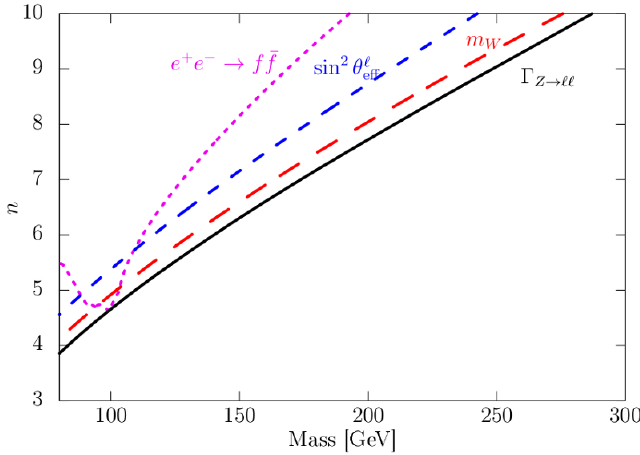
Figure 3 . The current constraints on Majorana fermion with hypercharge zero from the electroweak precision measurements. The region above each line is excluded at 95% con(cid:12)dence level. on a Majorana fermion with hypercharge zero are shown in (cid:12)gure 3. The SU(2) number ‘ n ’ is formally treated as a real number to depict the (cid:12)gure. All the constraints are given at 95% con(cid:12)dence level, which are obtained from the measurement of the W boson mass m (observed value: 80 : 379 0 : 012 GeV & SM prediction: 80 : 361 W (cid:6)